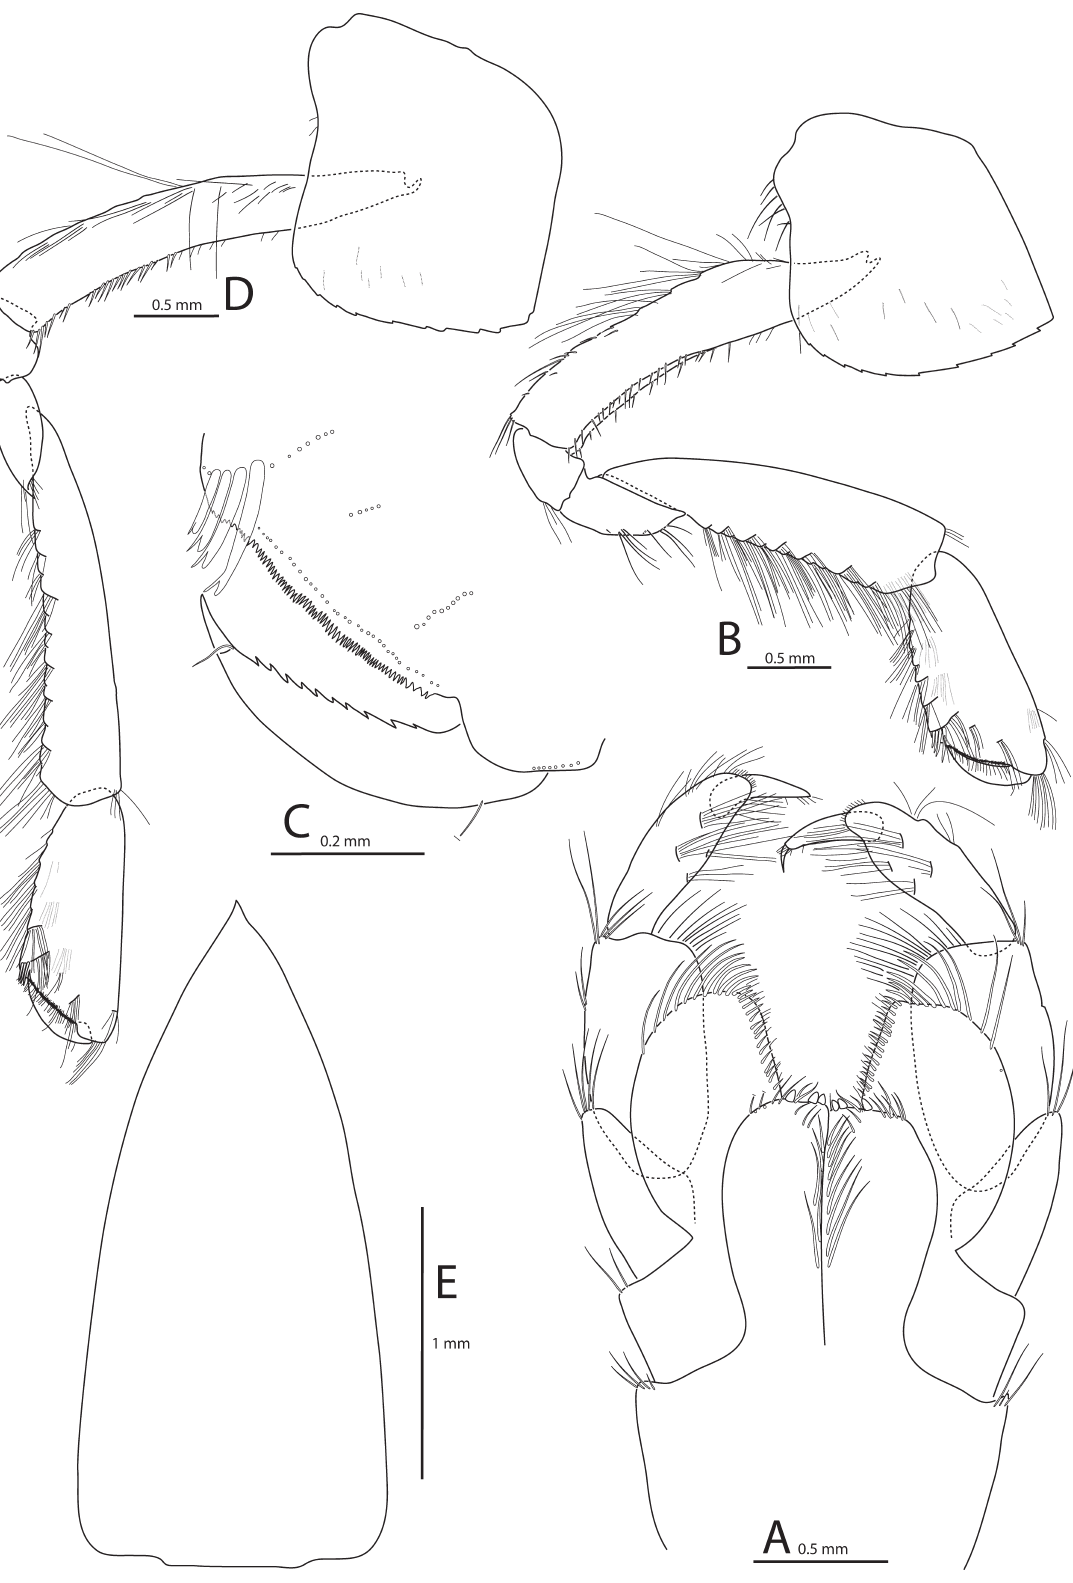
Fig. 4. Halirages cainae sp. nov., holotype ♂, 40 mm, Norwegian Sea, MAREANO 2009-111, R-station 487, sample 157. A . Mxp. B . right Gn1. C . tip of chela of right Gn1. D . right Gn2. E .